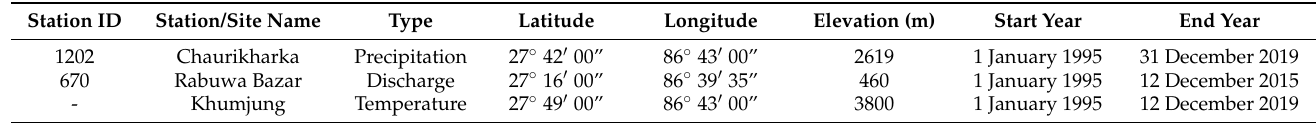
Table 1. Detailed information on climate stations used in this